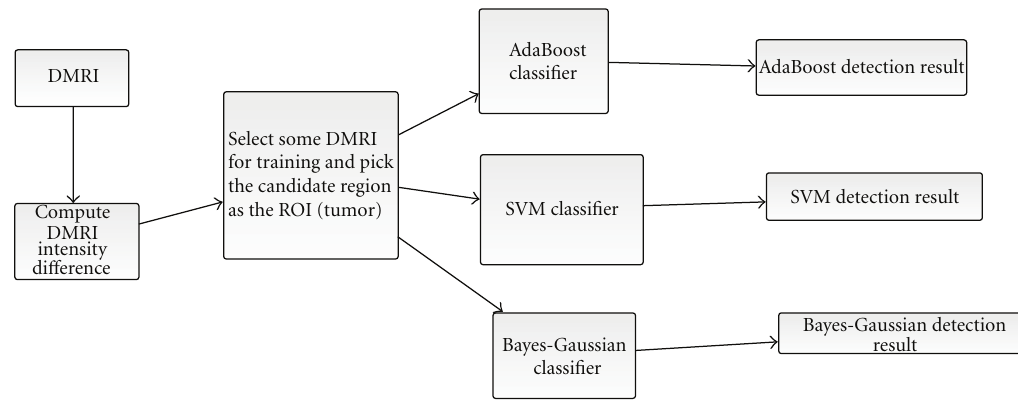
Figure 1: The proposed system framework.